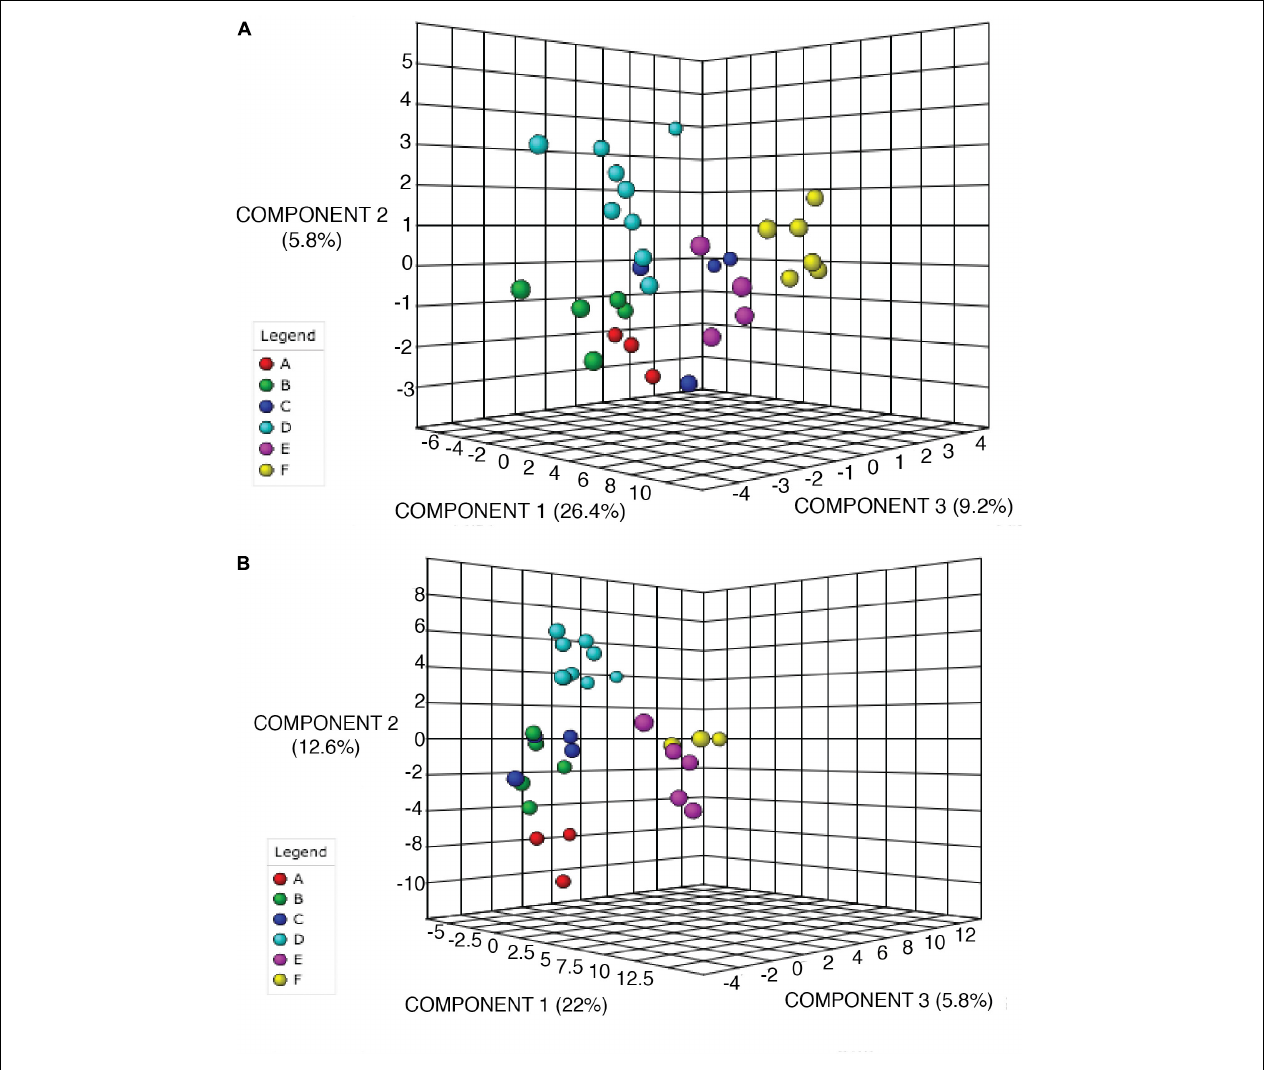
FIGURE 3 | PLS-DA of alkaloid and phenolic extractions depicts differentiation between sites. 3D scores plot between selected PCs. The explained variances are shown in brackets. Site locations (A–F) are color-coded and ID’s refer to Table 1 . (A) PLS-DA for alkaloid extraction (B) PLS-DA for phenolic